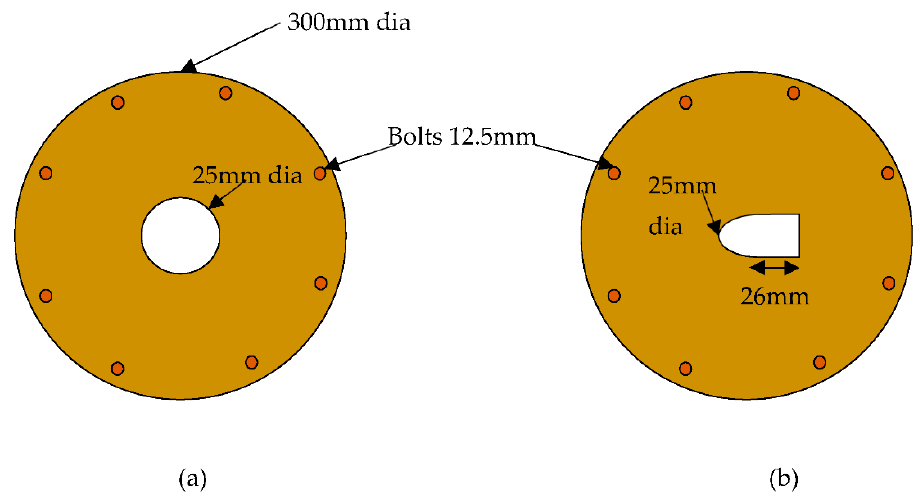
Figure 2. Geometry of the top plates for the axial and lateral loading test (not to scale). ( a ) Top plate for axial loading; ( b ) top plate used for lateral loading.